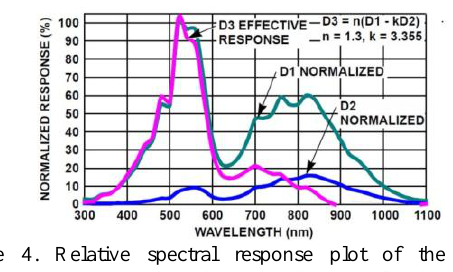
Parameters of the UAV flight on 2.7.2012. Disturbed layers are in slanted and the layers 7, 16 and 29 are in